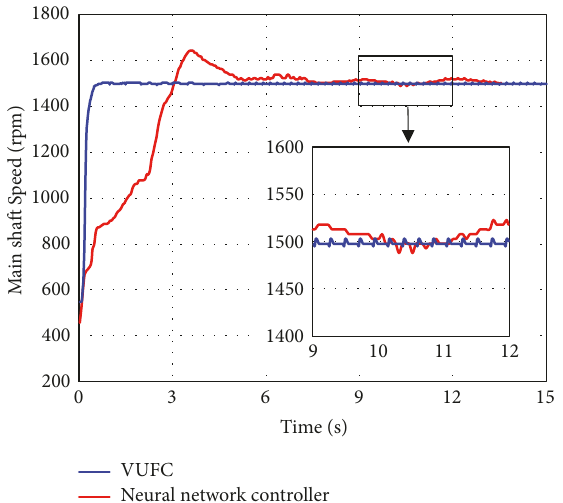
Figure 8: Drive chain performance comparison between the proposed VUFC and the neural network